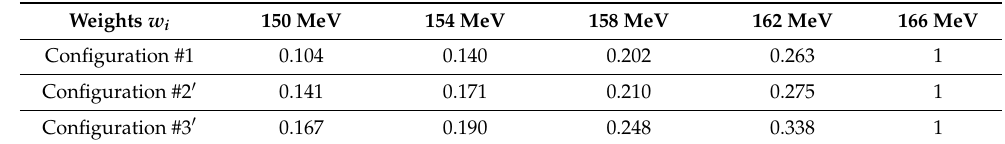
Table 3. Normalized weights w i obtained with genetic optimization of the 3 cm wide SOBP in the reference Configuration #1 and in the two configurations with magnetic fields and a dynamic